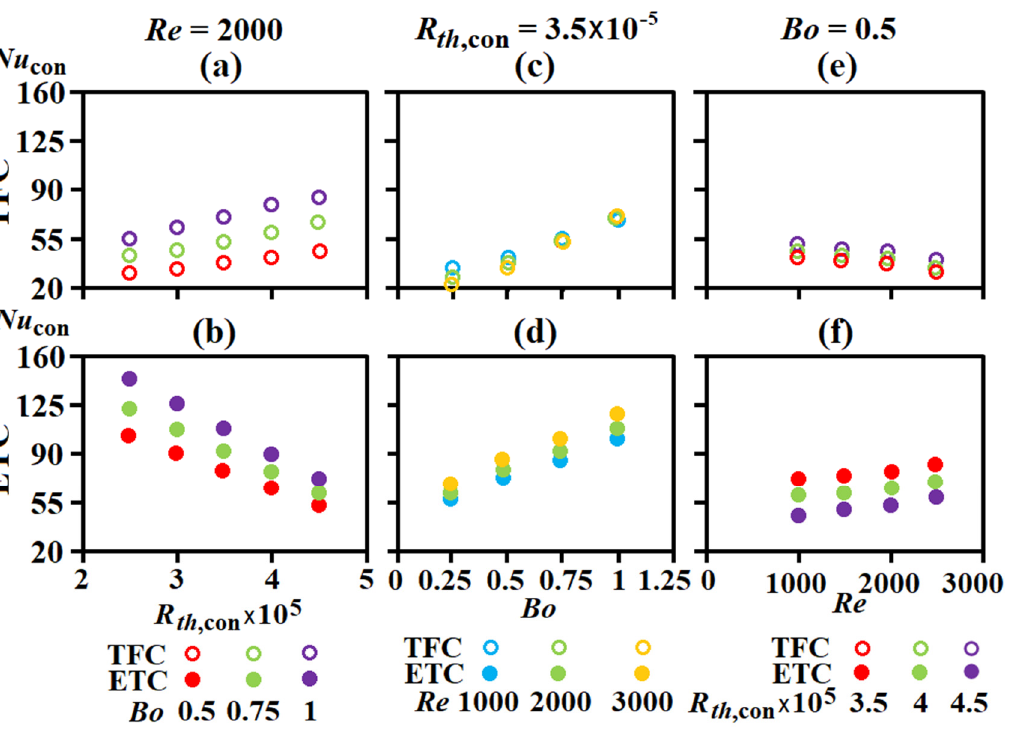
Figure 6. Variations of Nu con along with ( a , b ) R th ,con at Re = 2000 ( c , d ) Bo at R th ,con = 3.5 × 10 -5 . ( e , f ) Re at Bo = 0.5 between the loops with TFC and ETC.